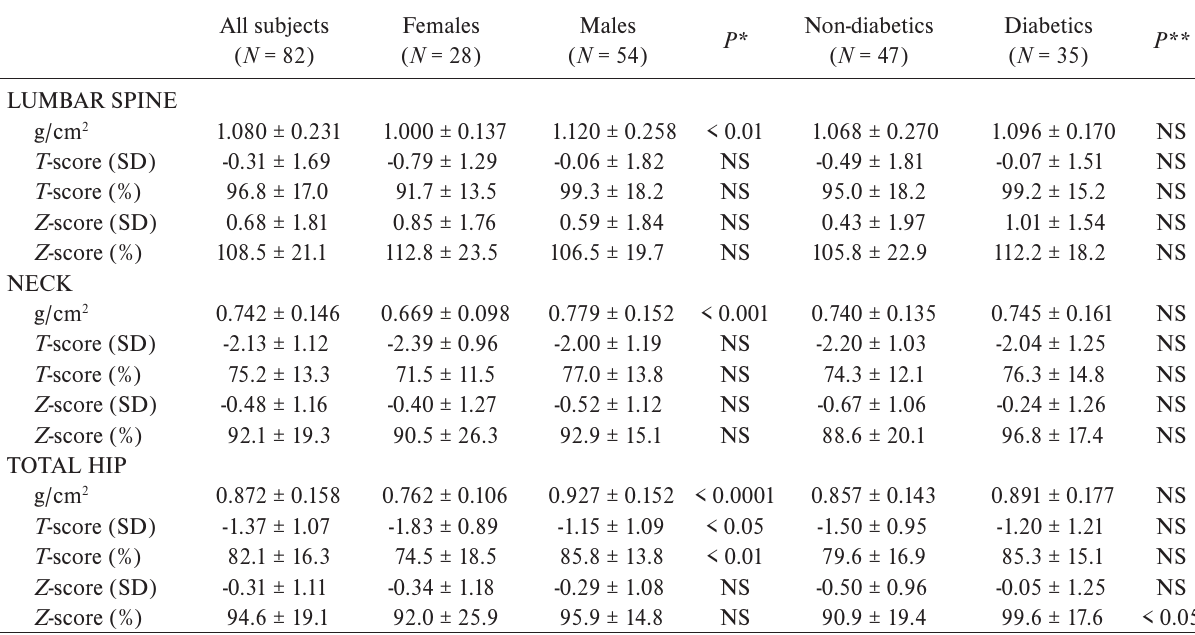
Table 2. Bone densitometric data for all subjects and for subgroups of females, males, non-diabetics and